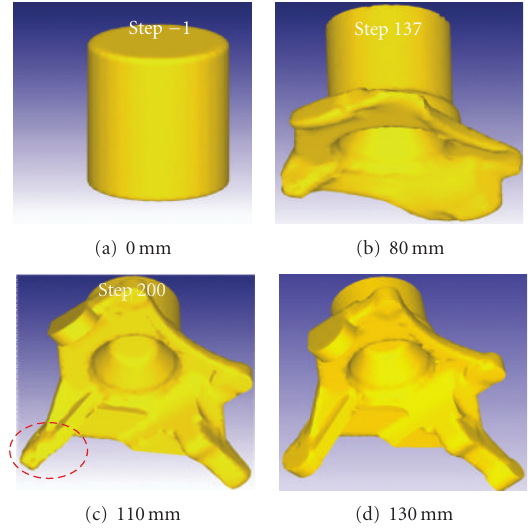
Figure 29: Shape change results according to punch stroke in DEFORM 3D.